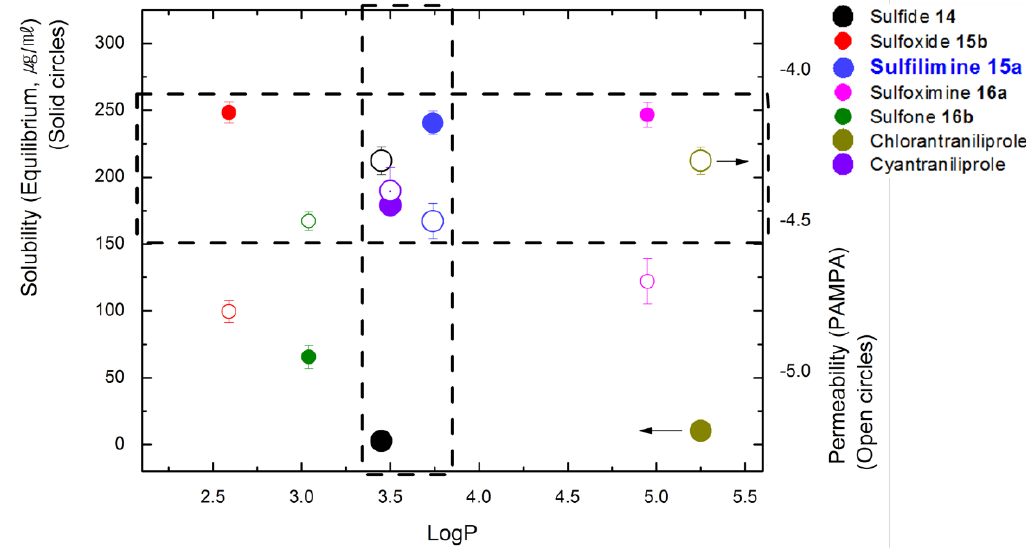
Figure 3. Physical properties of organosulfur-substituted anthranilic diamides 14 – 16 [38–40]: Open and solid circles represent permeability (parallel artificial permeability assay, PAMPA) and solubility (equilibrium), respectively; horizontal dash box describes similar permeability (PAMPA) with chlorantraniliprole (dark yellow) and cyantraniliprole (violet); vertical dash box represents similar log P with cyantraniliprole (violet).